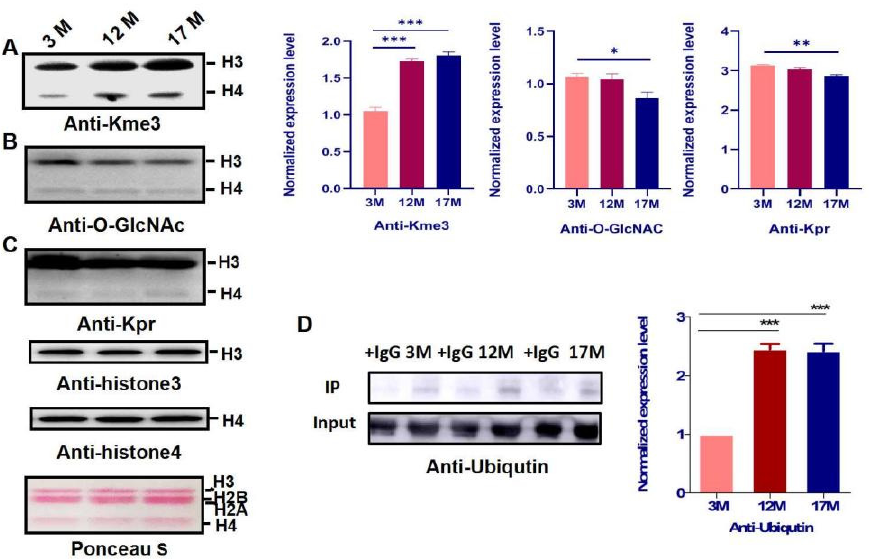
Figure 3. The histone modification level of Kme3 and ubiqutin, Kpr, and O-GlcNA of histone were altered during ovarian aging. ( A – C ) Ovaries histones in different age of mice were isolated and the level of Kme3, Kpr, and O-GlcNA modifications were examined by western blot and analyzed by quantifying the gray value of target bands normalized to those detected by Kme3, Kpr, and O-GlcNA using Image J software. ( D ) ubiqutin was examined by IP methord and and analyzed by quantifying the gray value of target bands normalized to those detected by ubiqutin using Image J software. Bar: mean ± SEM, * p < 0.05, ** p < 0.01, *** p <